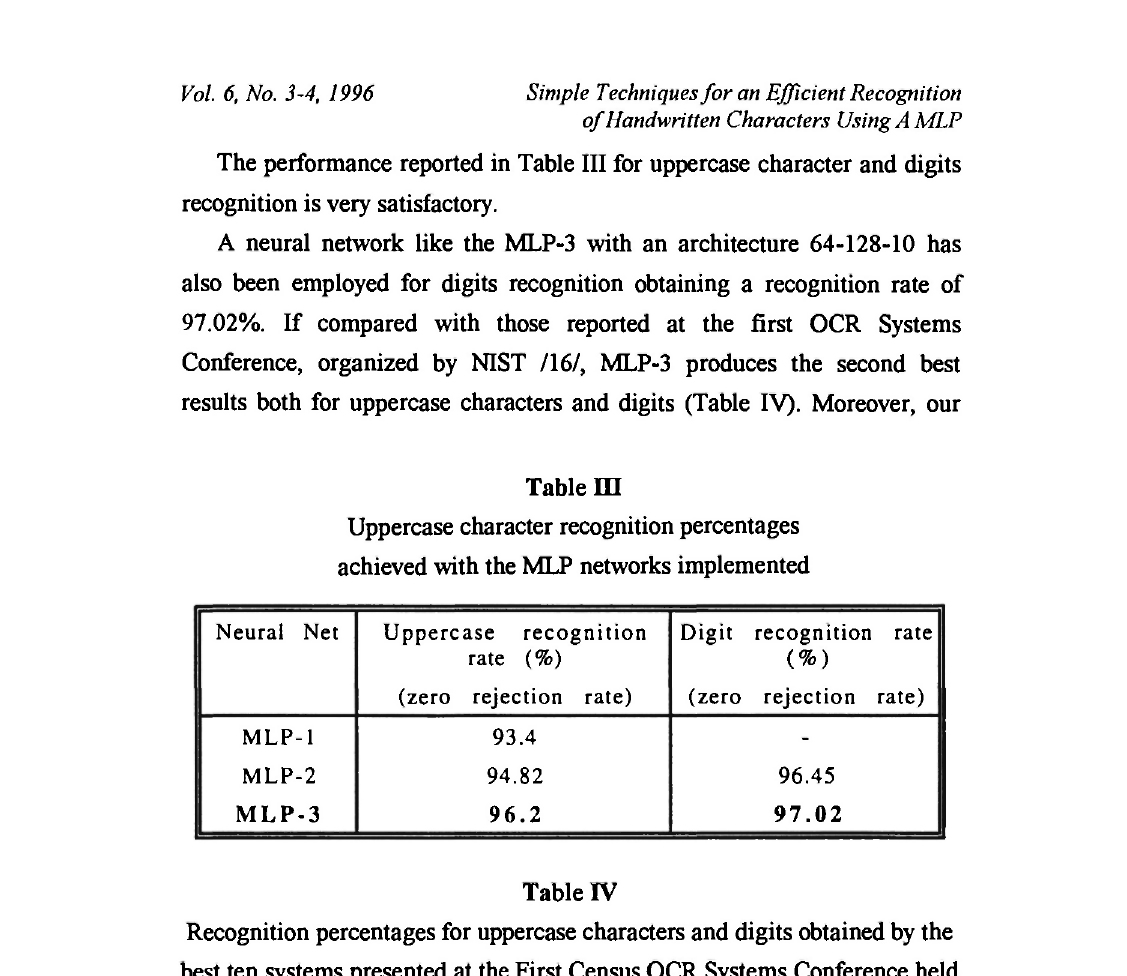
Recognition percentages for uppercase characters and digits obtained by the best ten systems presented at the First Census OCR Systems Conference held by NIST in